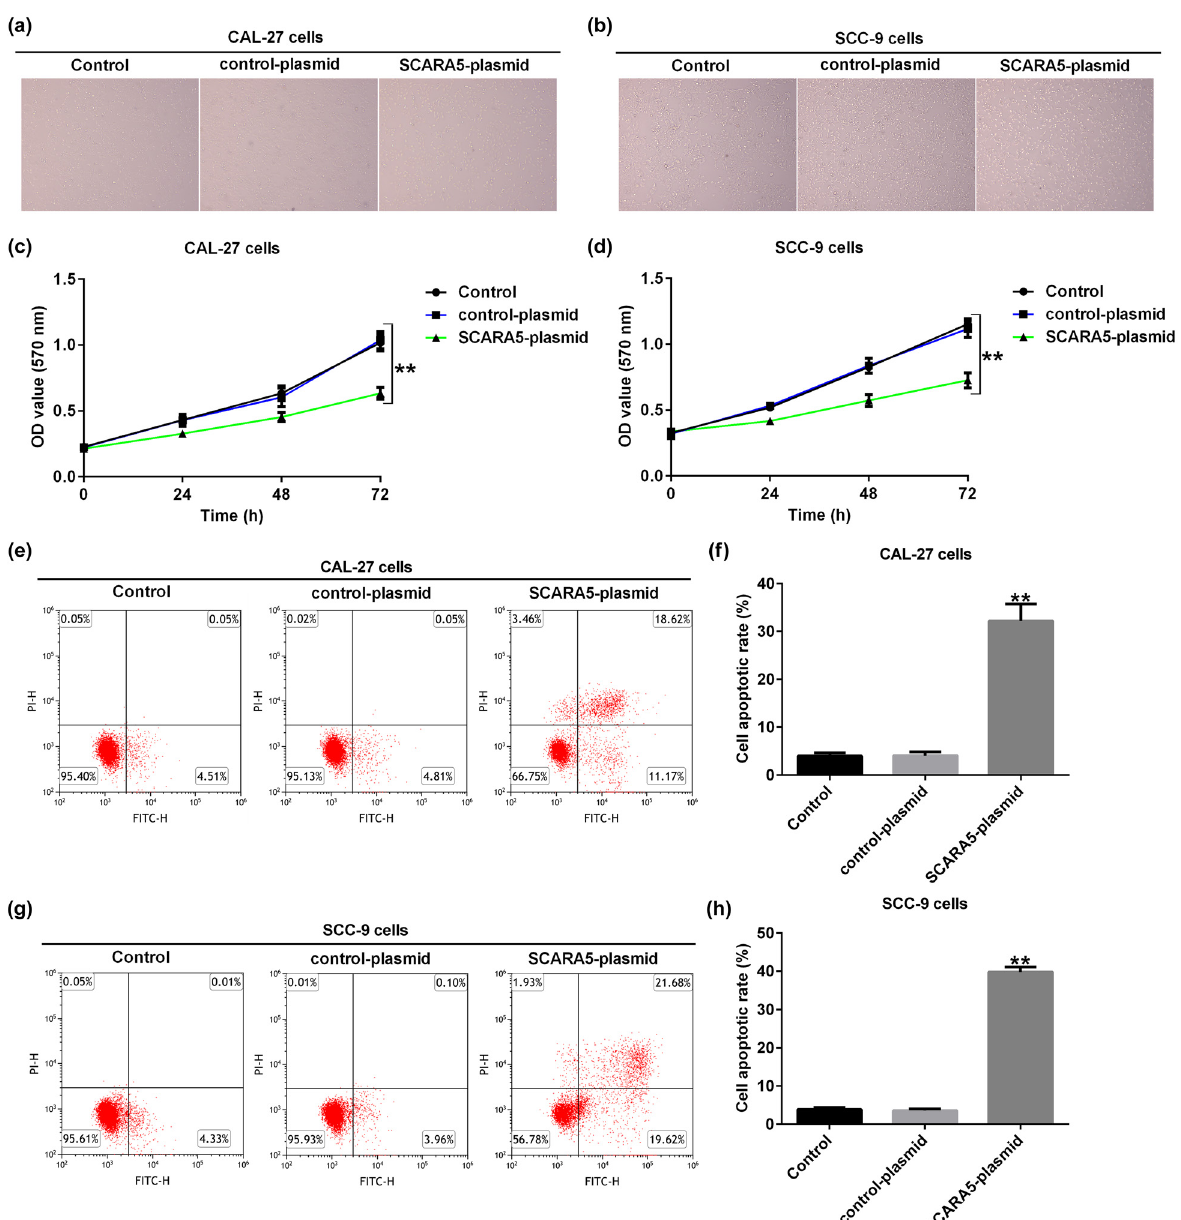
Figure 3: E ff ects of SCARA5 on the proliferation and apoptosis of CAL - 27 and SCC - 9 cells. Control plasmid or SCARA5 plasmid was transfected into CAL - 27 and SCC - 9 cells for 48 h. ( a ) The light microscope picture of cell morphology from di ff erent groups in CAL - 27 cells. ( b ) The light microscope picture of cell morphology from di ff erent groups in SCC - 9 cells. ( c ) MTT analysis of cell viability of CAL - 27 cells was carried out at 24, 48, and 72 h. ( d ) MTT analysis of cell viability of SCC - 9 cells. ( e ) FCM assay of cell apoptosis of CAL - 27 cells. ( f ) Cell apoptosis rate was presented by Graphpad 6.0. ( g ) FCM assay detected the cell apoptosis of SCC - 9 cells. ( h ) Cell apoptosis rate was presented by Graphpad 6.0. ** p < 0.01 vs control